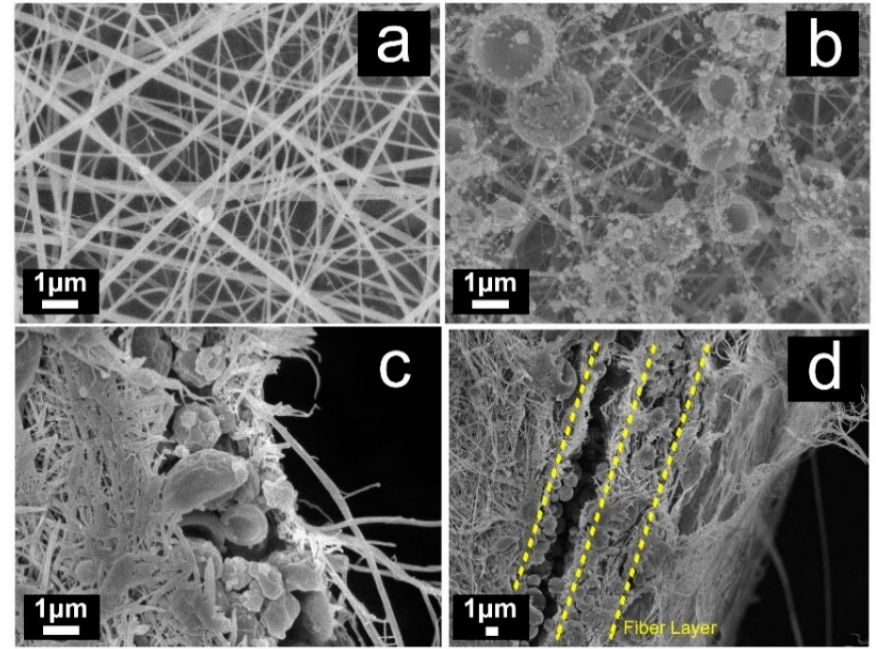
Figure 3. The morphologies of CS stacking membranes: ( a ) CS-L1, ( b ) CS-L2, ( c ) CS-L3 cross section and ( d ) CS-L5 cross section.